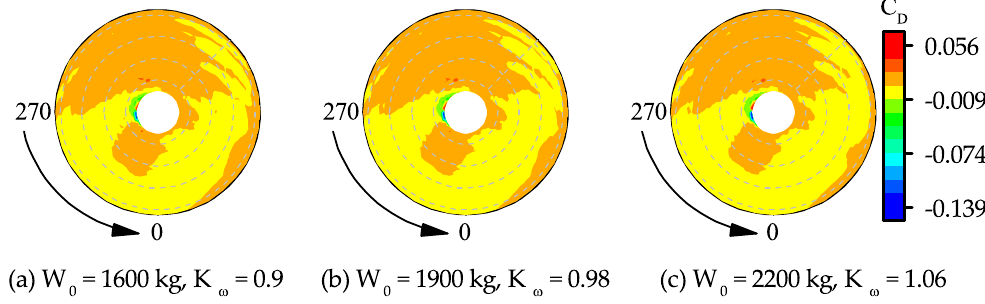
Figure 8. µ = 0.15, drag coefficient, C D , with rotor speed.